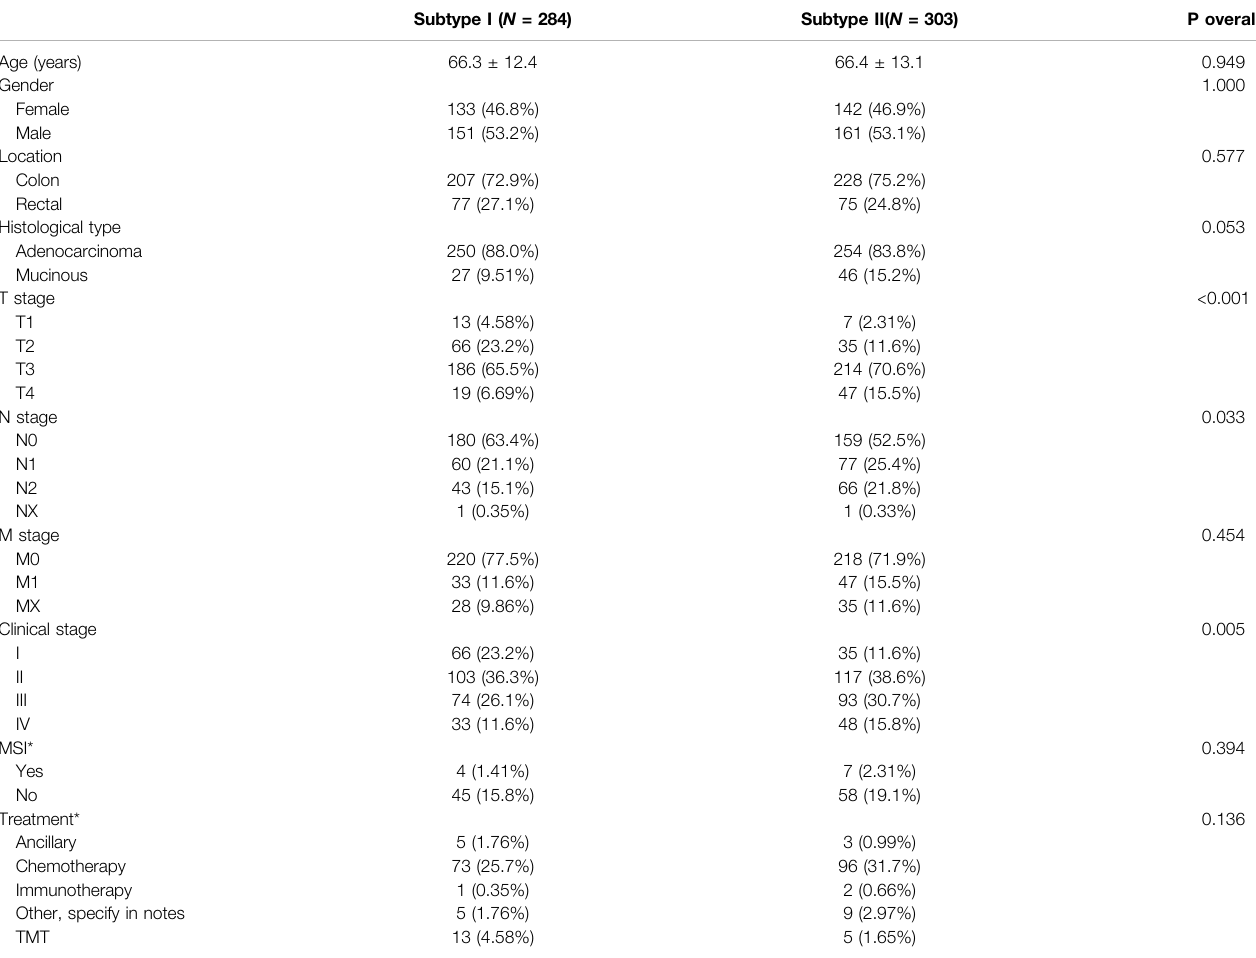
TABLE 2 | Comparison of clinical features between subtype I and subtype